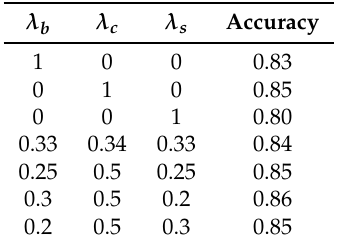
Table 6. λ impacts on recognition